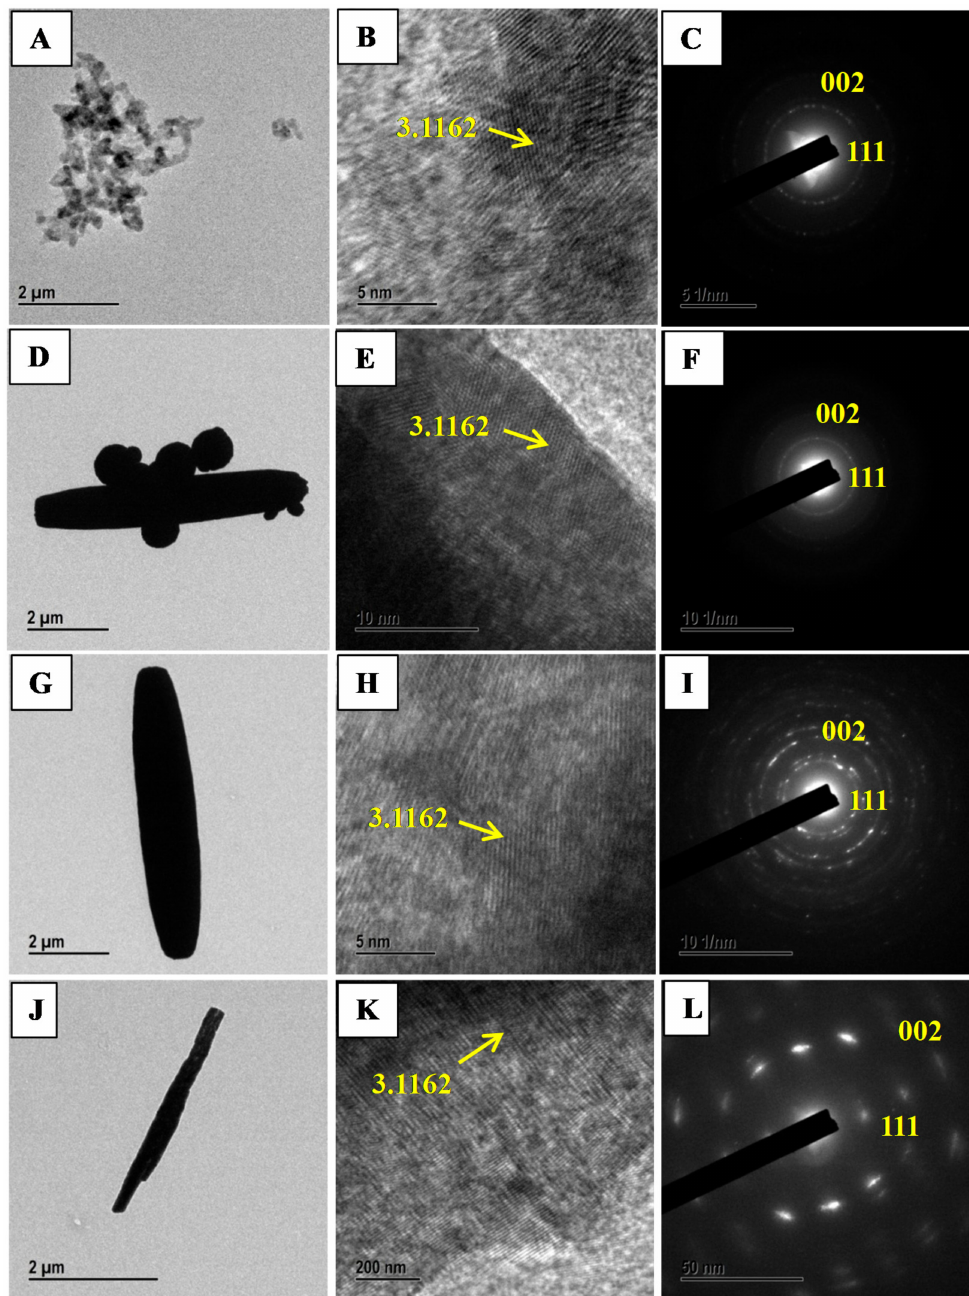
Figure 2. Transmission electron microscopy (TEM), High-resolution transmission electron microscopy (HRTEM), and selected area electron diffraction (SAED) images of SphereCeO 2 ( A – C ); mixed shape CeO 2 ( D – F ); CeO 2 spindles ( G – I )